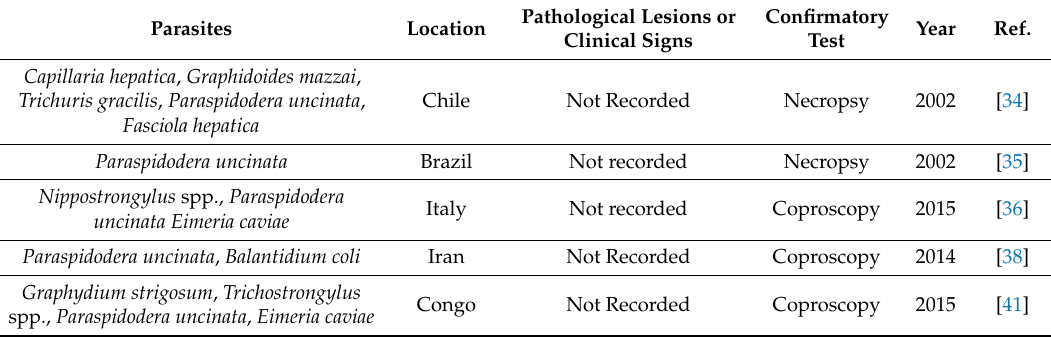
Table 3. Gastrointestinal Parasites present in Guinea pigs and its effect on the animals. Parasites Location